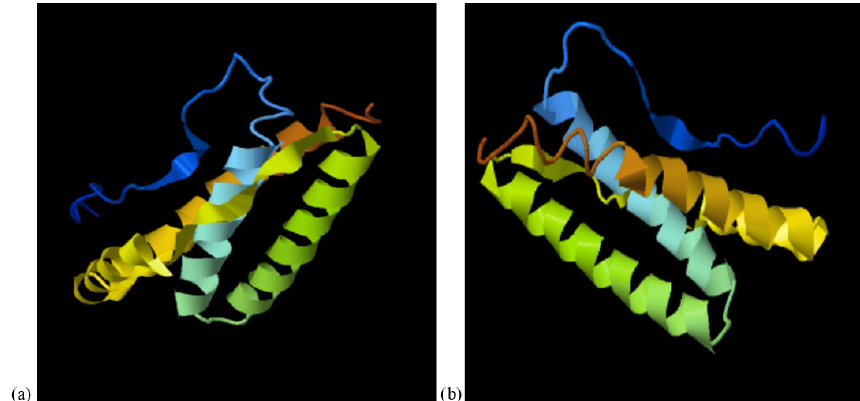
Figure 3. The predicted 3D tertiary structure of the Anatolian water buffalo leptin peptide; (a) native structure and (b) the effect of the detected amino acid changes on its 3D tertiary structure. Table 3. The genotype and allele frequency belong to some SNPs of the Lep gene in Anatolian water buffaloes. SNP position N